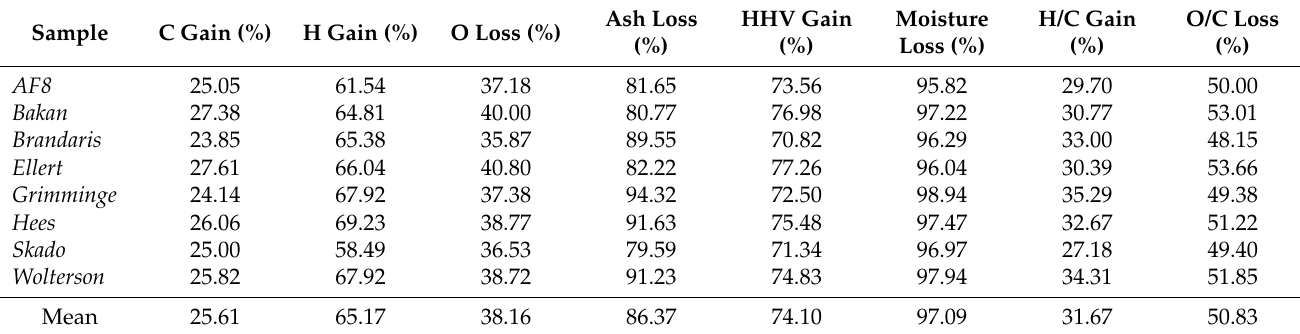
Table 3. Ratios of C, H, HHV H/C gain and of O, Ash, Moisture, and O/C loss of the bio-oils obtained from the liquefaction of poplar clone samples.